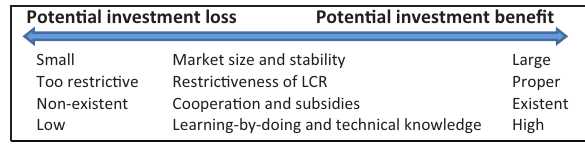
name of transitioning to more environmentally-friendly means of developing energy (Kuntze & Moerenhout 2013:vi).